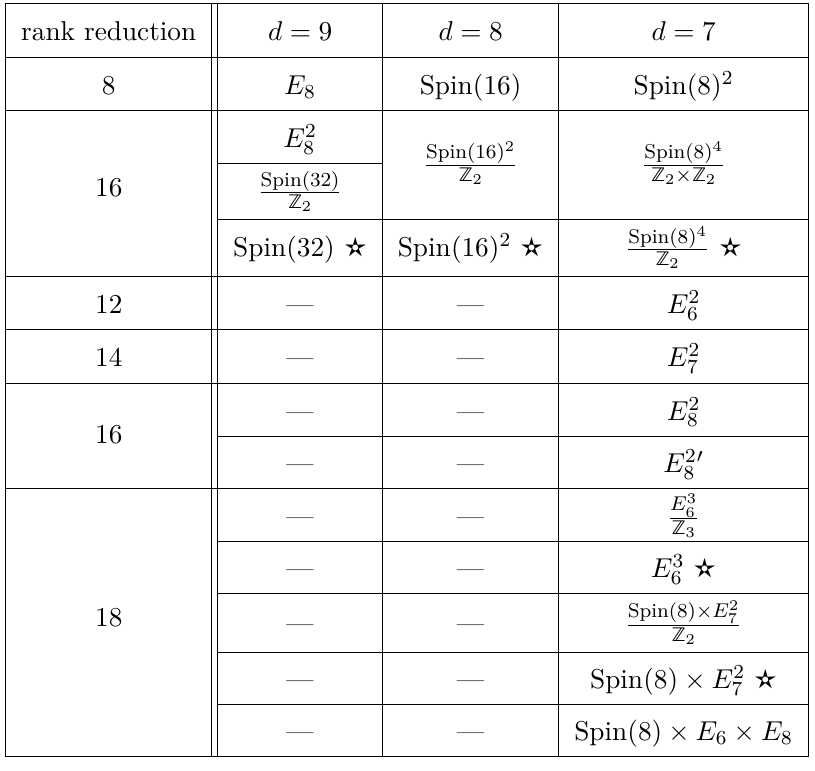
Table 1 . Gauge groups corresponding to the singularity freezings producing the different moduli space components in d ≥ 7 string theories with 16 supercharges. The leftover rank in each case is equal to 26 - d -rank reduction. All fundamental groups are diagonal. The two E 2 level of the M-Theory 3-form field background which produces the freezing. Items labeled with K correspond to new components. The case of seven dimensions refines table 1 of